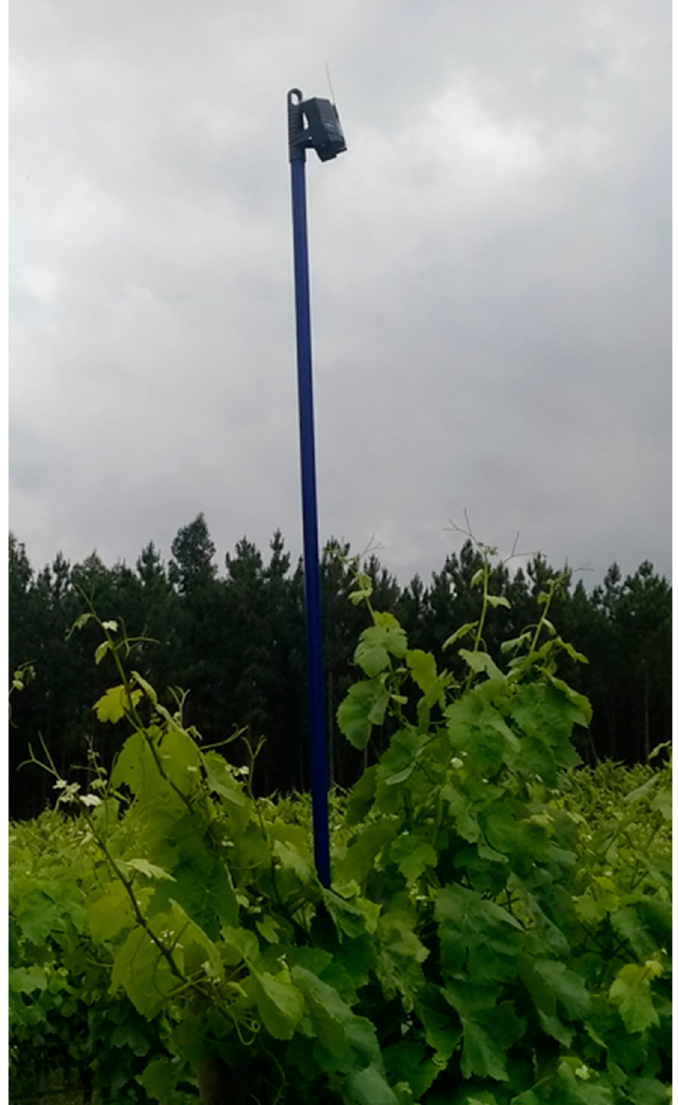
Figure 4. An infrastructure beacon placed above the vines’